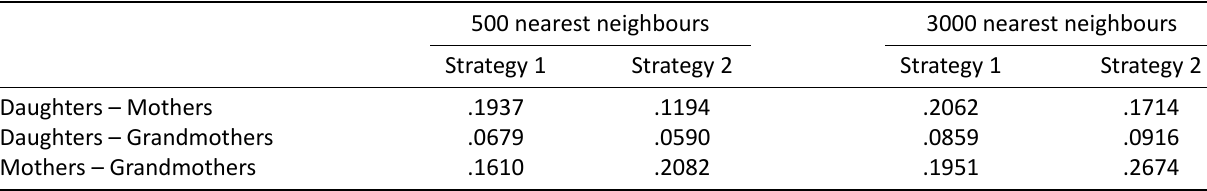
Table 2. Correlation